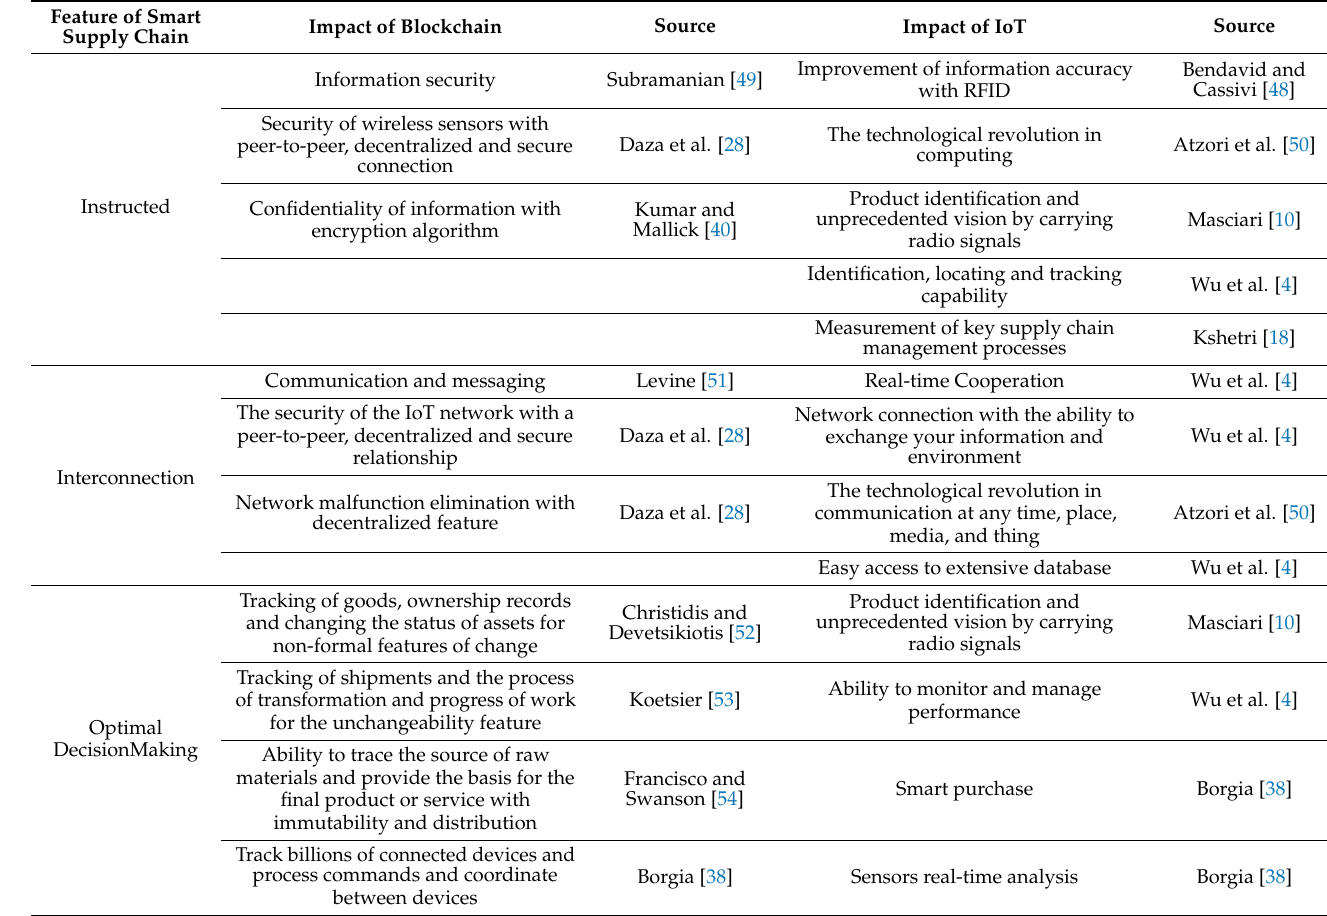
Table A1. Summary of provision of model and data